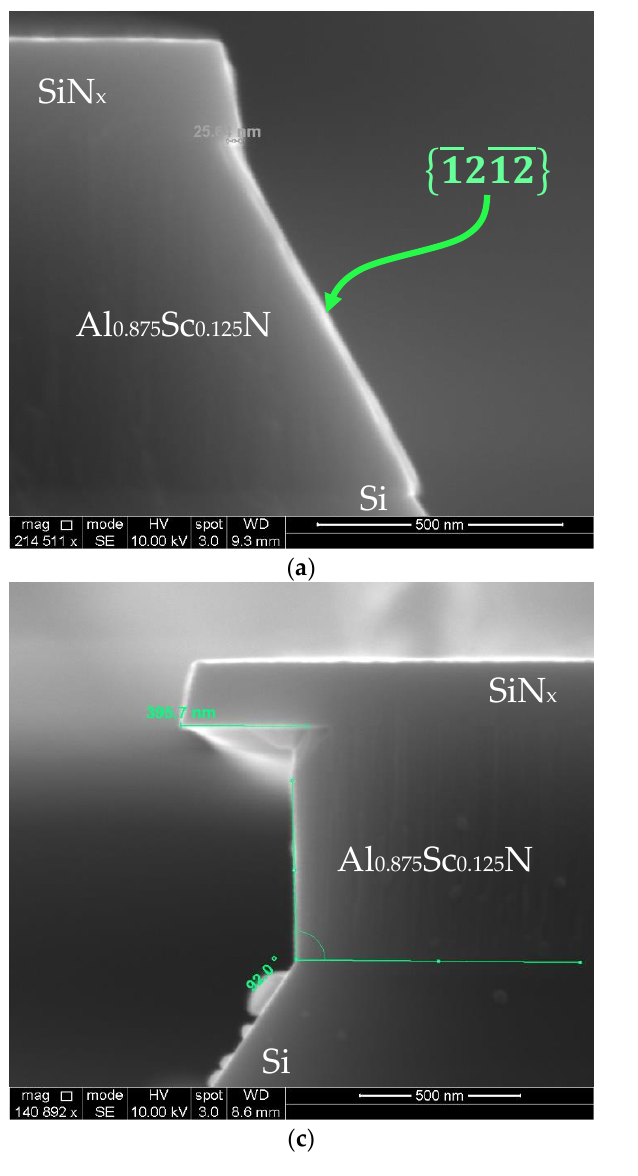
Figure 12. Lateral etch of Al 0.875 Sc 0.125 N in ( a ) 30% KOH at 45 °C for 10 min; ( b – d ) 10% KOH at 65 °C for 20 min.